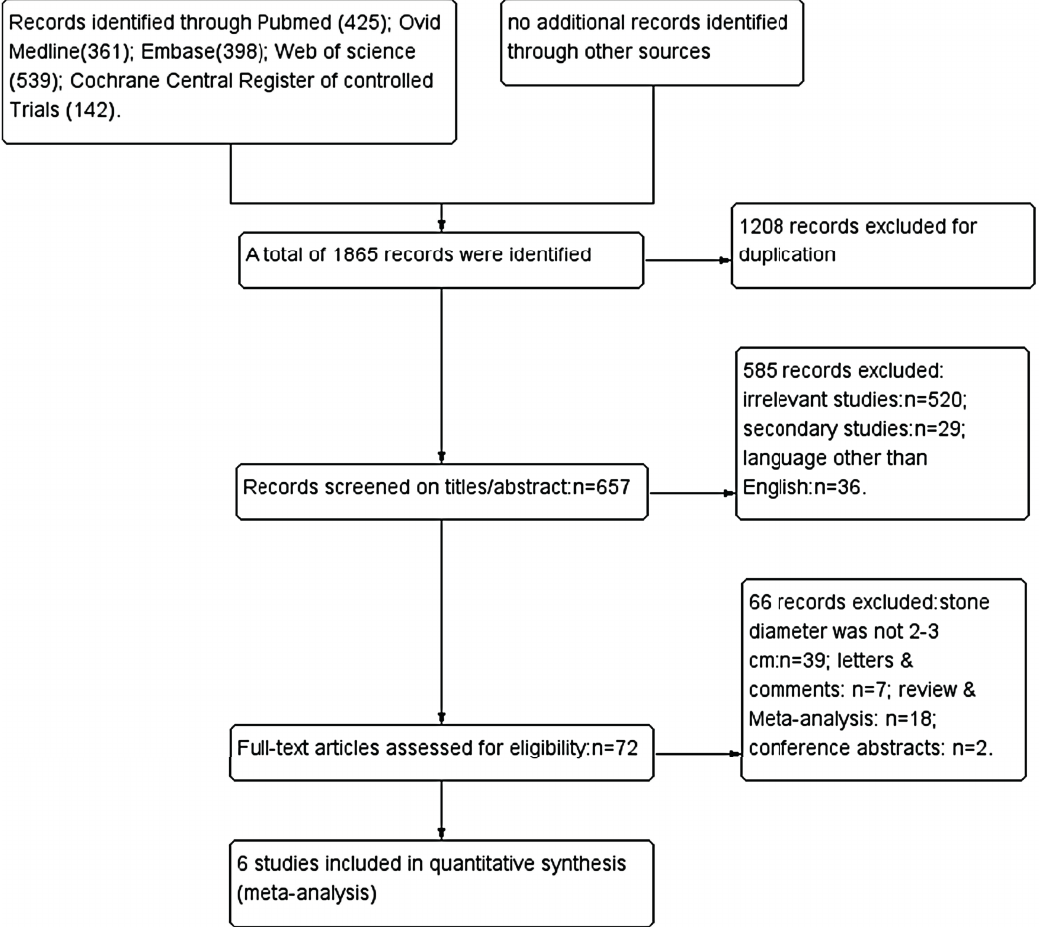
Figure 1 - Preferred Reporting Items for Systematic Reviews and Meta-analyses fl ow of study